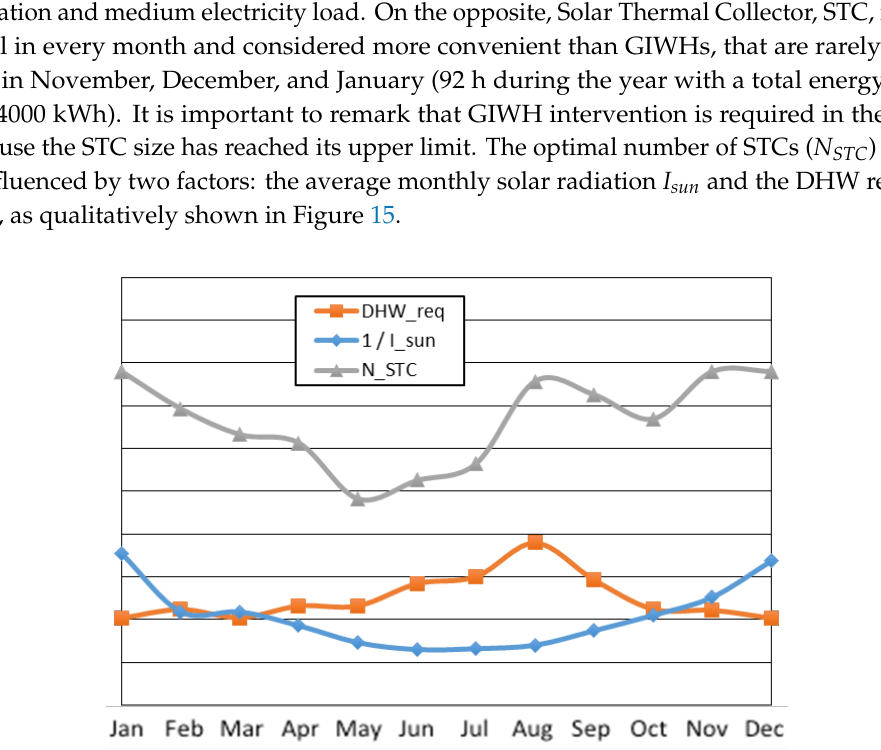
Figure 15. Solar thermal collectors STC size influence in monthly optimizations in the TO-BE scenario 2. In this figure DHW_req is the variable DHW req , , I_sun is the solar radiation and N_STC is the variable N